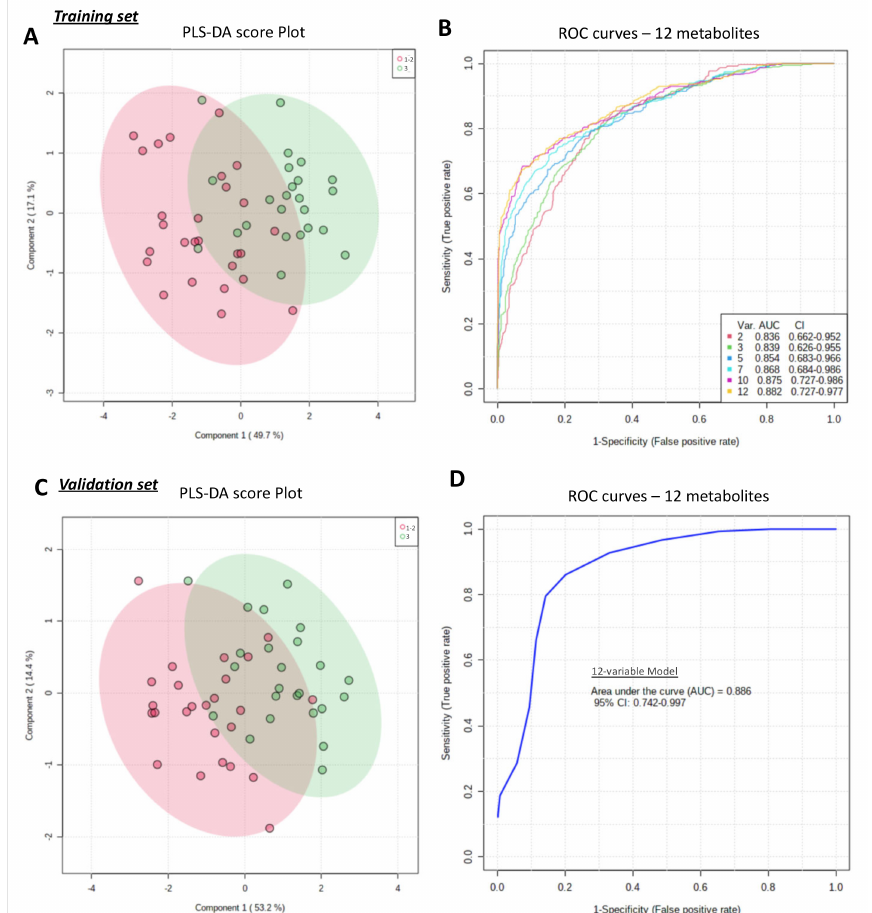
Figure 2. Metabolomic fingerprinting allowed accurate discrimination of SBR grades using the top 12 most important metabolites. The top 12 metabolites (N1,N12-Diacetylspermine, N’Formylkynurenine, N-(1-Deoxy-1-fructosyl)phenyalanine, fructoseglycine, malonylcarnitine, L-L-Homoglutathione, 5-Hydroxy-L-tryptophan, 8-Methpxykynurenate, L-Dopa, L-Kynurenine, N-Acetylproline and 5-Hydroxyindoleacetic acid) were determined from previous Partial Least Squares Discriminant Analyses (PLS-DA—see Figure 1A). ( A ) shows the score plot of the PLS-DA for the training set, which accurately discriminates between high-grade (grade III—green dots) and low-grade (grade I–II—red dots) groups. ( B ) shows the AUCs of the ROC of different metabolomic signatures in the training set, which included an increasing number of metabolites (var.), with